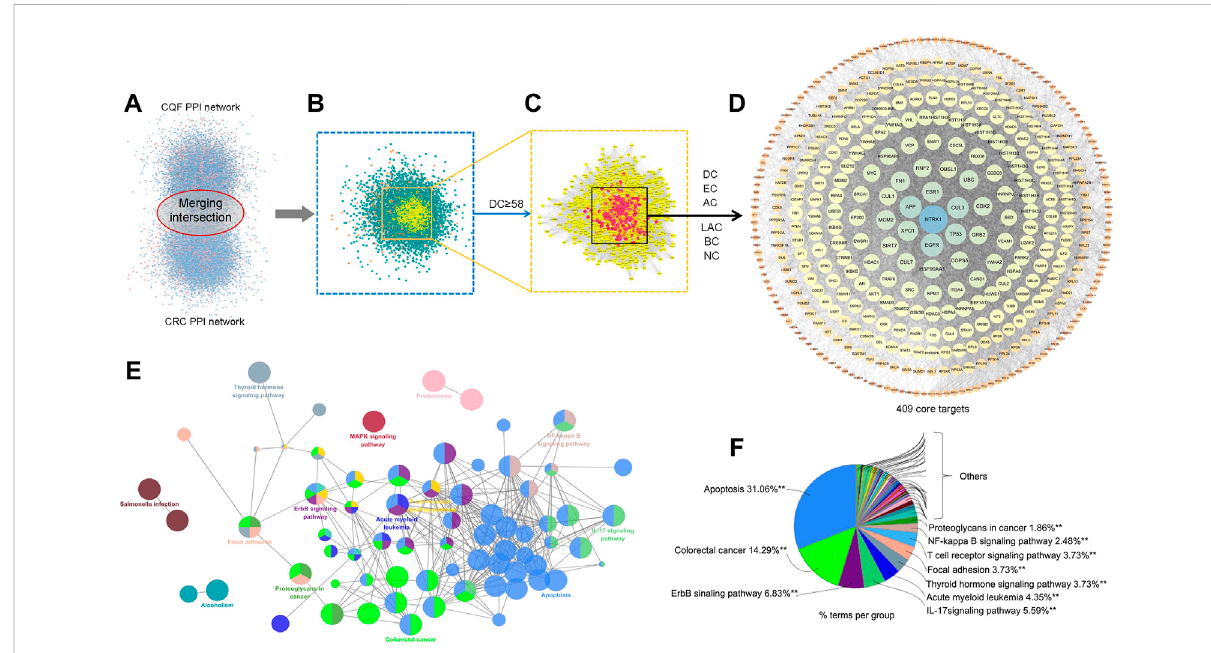
FIGURE 3 Core target identi fi cation and ClueGo pathway analysis. (A) PPI networks of CQF-related targets, consisting of 7,700 nodes and 178,773 edges, andCRC-relatedtargets,consistingof7,343nodesand176,169edges. (B) IntersectionPPInetwork,consistingof5,463nodesand147,155edges. (C) Hub PPI network, consisting of 1,307 nodes and 58,424 edges. (D) Core-target PPI network, consisting of 409 nodes and 17,708 edges. (E,F) A functionally grouped network of categories enriched for the target genes. GO terms are represented as nodes, and node size represents the signi fi cance of term enrichment. Functionally related groups partially overlapped. Only the most signi fi cant term in the group was labeled. Representative enriched pathway ( p < 0.05) interactions among the main CQF